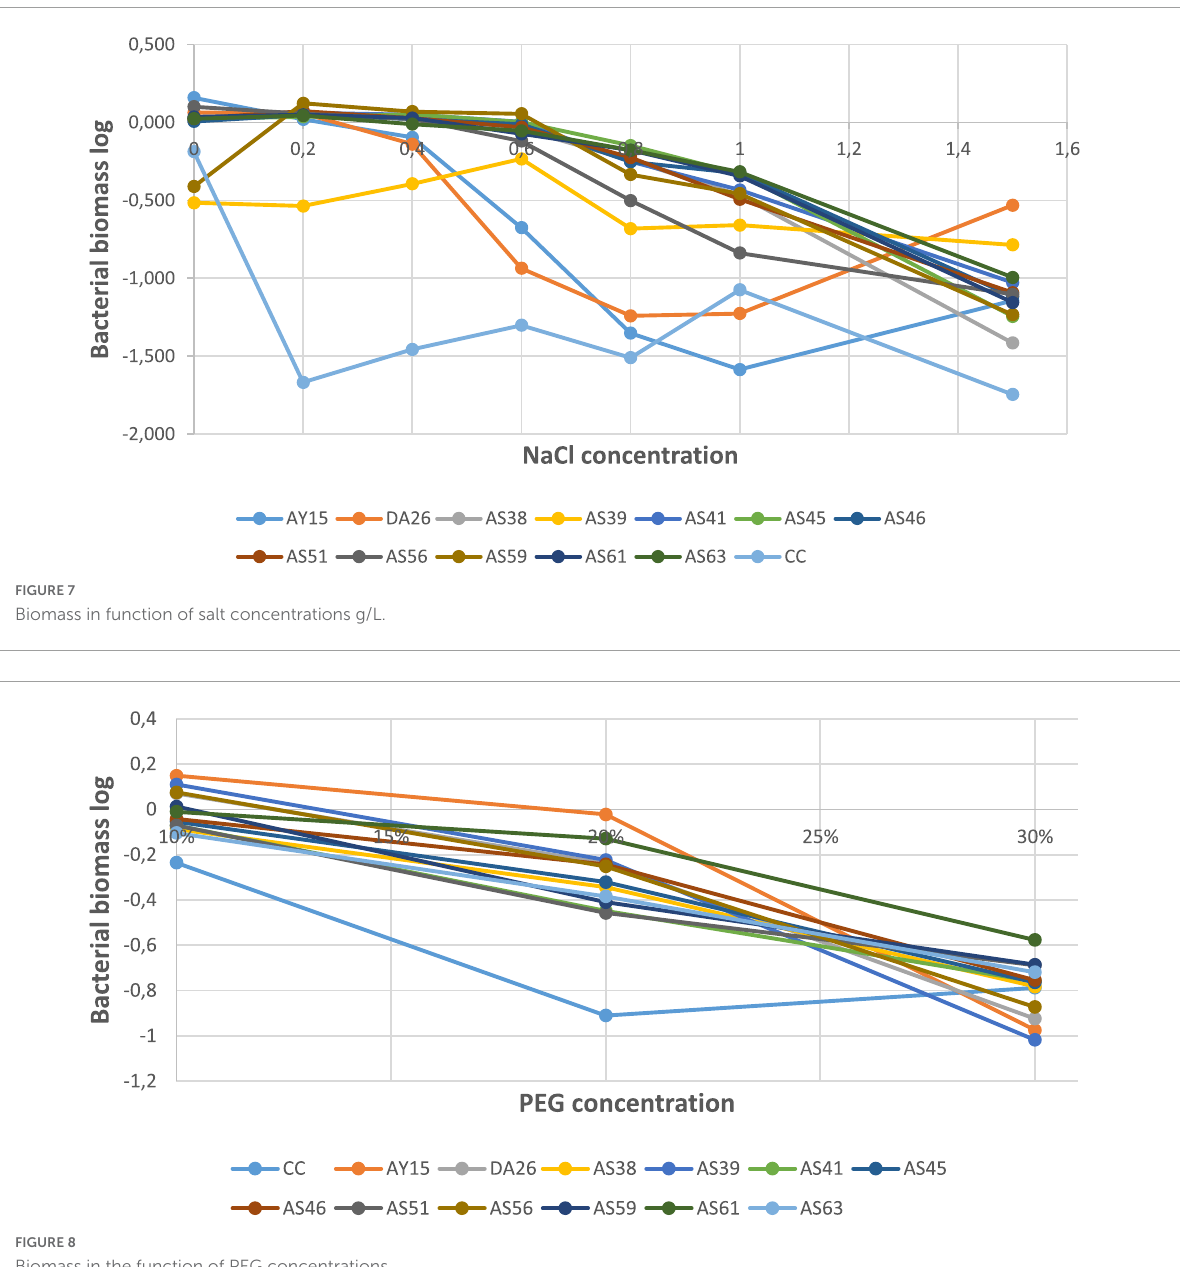
FIGURE8 Biomass in the function of PEG